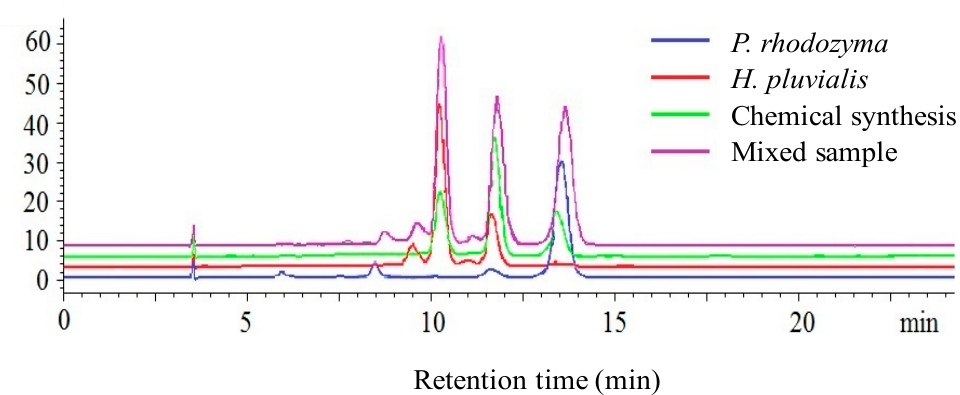
Figure 2. High-performance liquid chromatography (HPLC) analysis of P. rhodozyma , H. pluvialis , and synthetic astaxanthin at 25, 30, and 15 µ g / mL, respectively, and of their